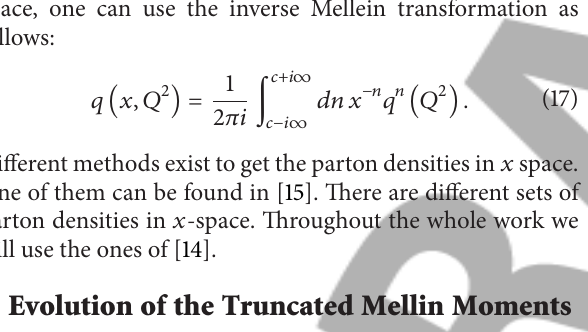
different values of 𝑄 2 . We plot in Figure 1 the first and second moment of parton densities versus 𝑄 2 , using (15). We use the valence parton density in [14] at 𝑄 2 0 = 0.34 GeV 2 as the input parton